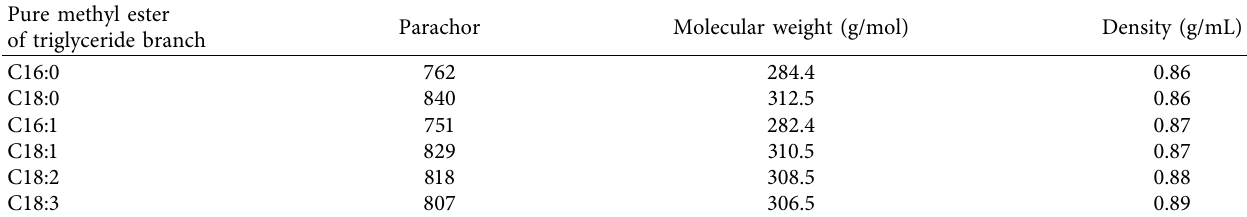
Table 1: Sugden’s Parachor and physicochemical property in each pure methyl ester of triglyceride branch [9]. Pure methyl ester Parachor Molecular weight of triglyceride branch